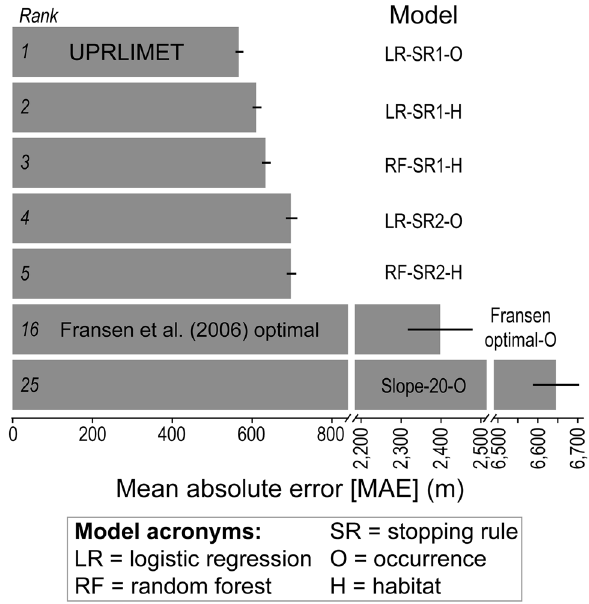
Figure 3. Comparison among selected models ranked by mean absolute error (MAE; m) of linear distance between the observed upper limit and the predicted upper limit. For the top five models, the model description specifies the development algorithm [ e.g., Random Forest (RF) or logistic regression (LR)], the stopping rule (SR) and its number (1, 2, or 3), and the type of training data [occurrence (O) or habitat (H)] used. In addition to showing the MAE for the top five models, two additional models are included, the Fransen et al. 13 model,